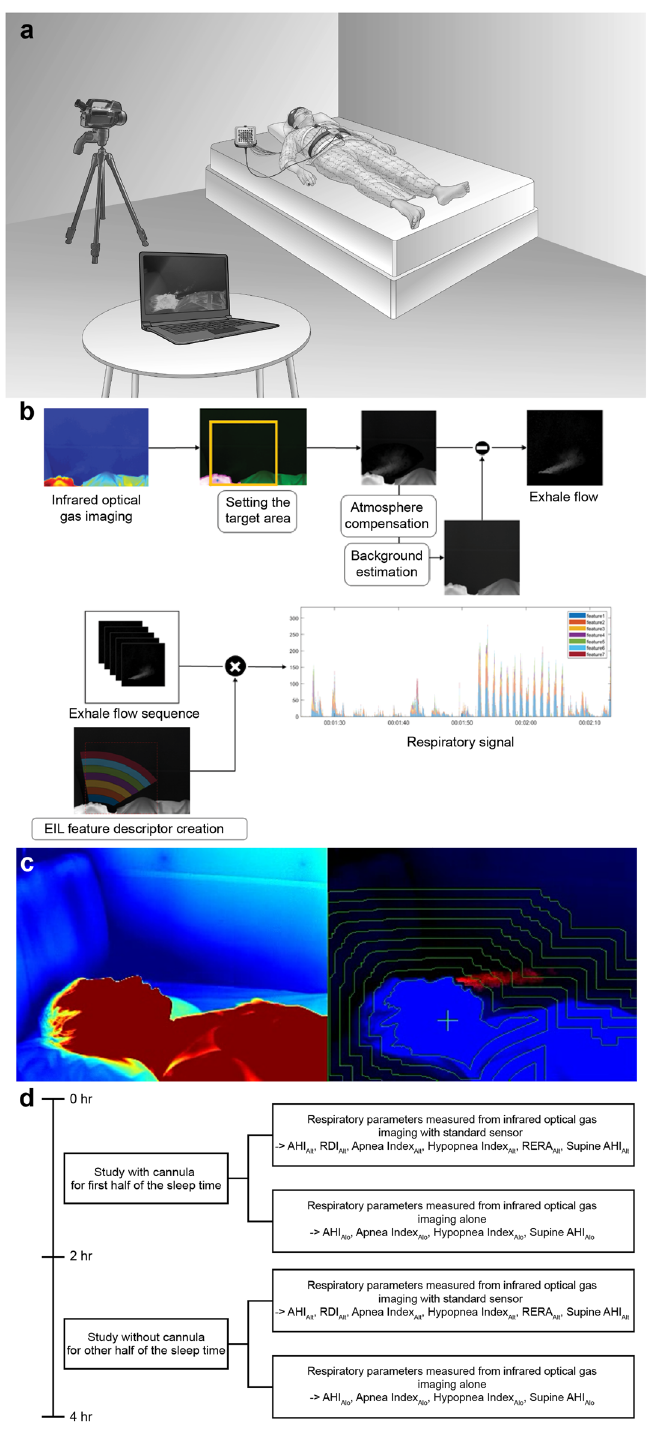
Figure 1. ( a ) Simplified depiction of the experimental setting(created with Adobe illustrator). Infrared optical gas imaging and polysomnography data were obtained simultaneously. The camera was placed 1.6 m from the patient’s face. ( b ) Algorithm for the detection of respiratory events from infrared optical gas images. ( c ) Pre(left) and post(right) images of digital image processing. The video presentation can be viewed online (Additional file 1: Video 1). ( d ) Study design. AHI apnea–hypopnea index, Alo infrared alone, Alt infrared with standard sensor, EIL equal-interval layer, RDI respiratory disturbance index, RERA respiratory effort-related